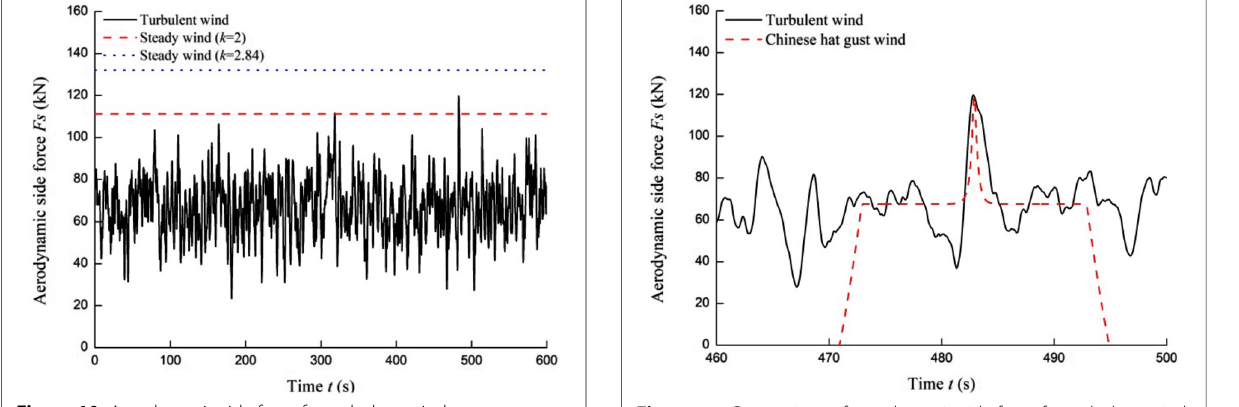
Figure 10 Aerodynamic side force for turbulent wind Figure 11 Comparison of aerodynamic side force for turbulent wind and gust